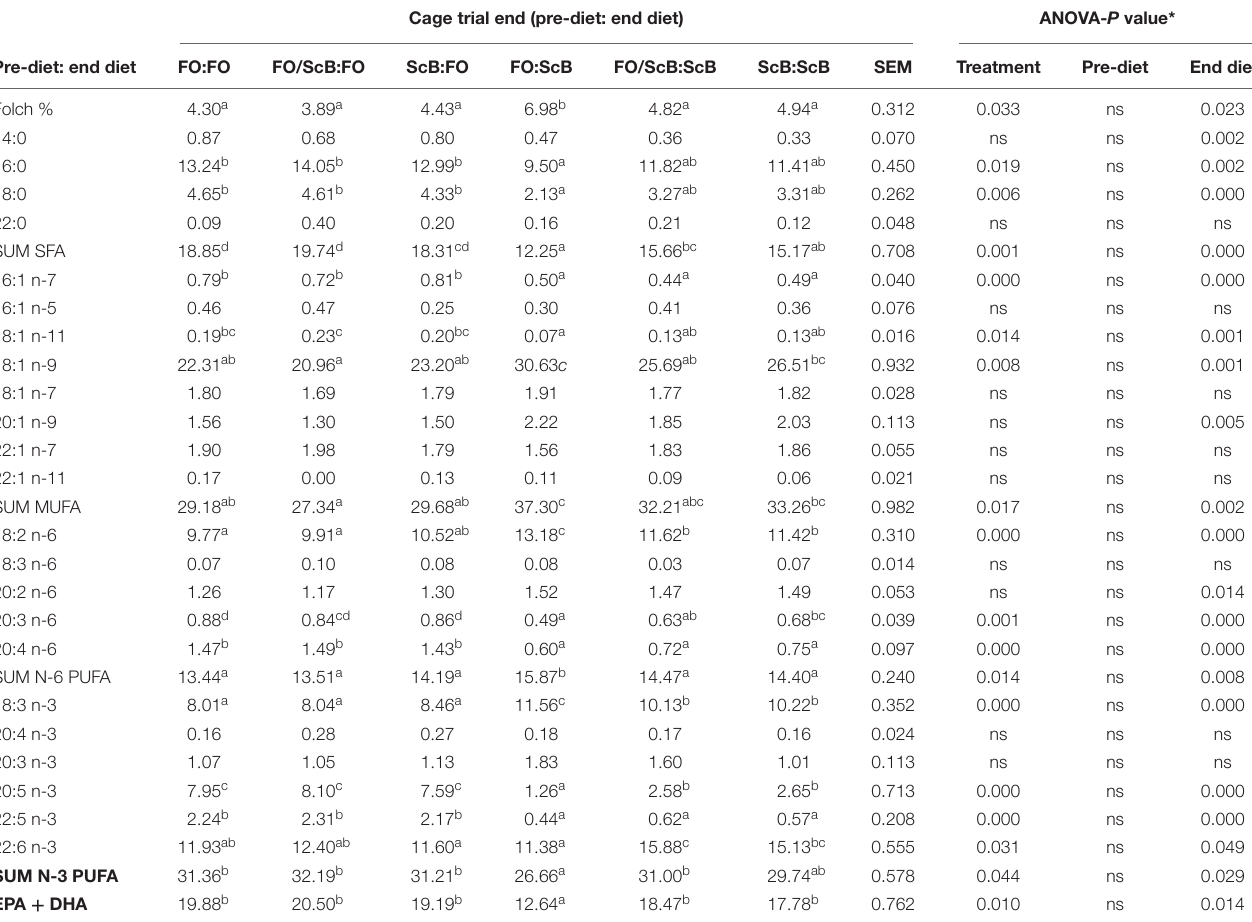
TABLE 6 | Fatty acid composition in liver of A. salmon fed life-long diets supplemented with FO, ScB, or a mix of the two until 0.8 kg body weight and either FO or ScB to slaughter. Cage trial end (pre-diet: end diet) ANOVA- P